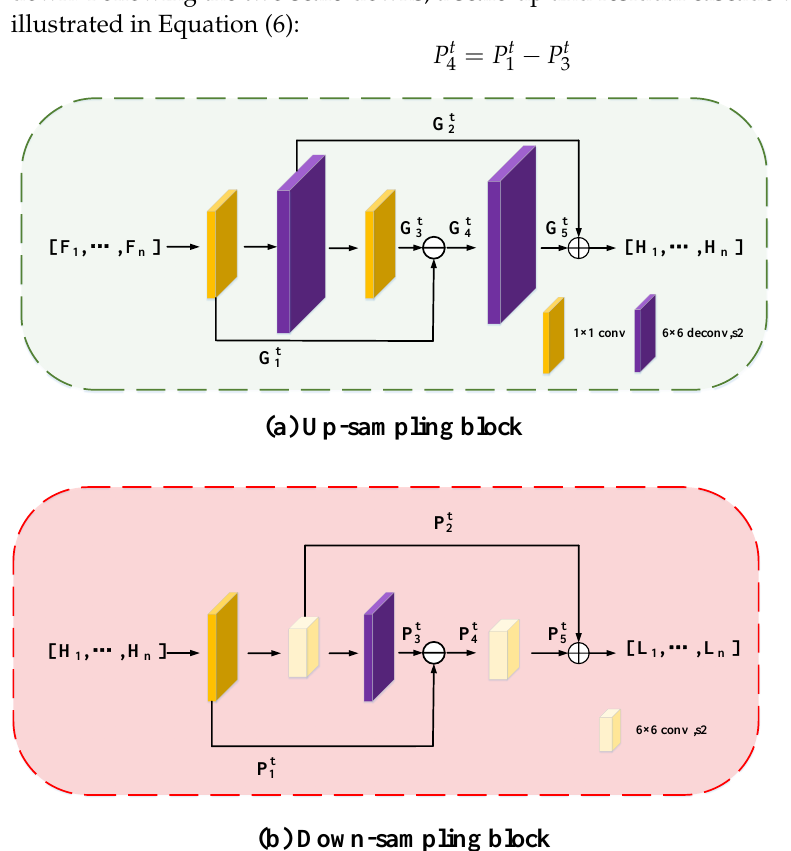
Figure 5. Sampling block in Aircraft